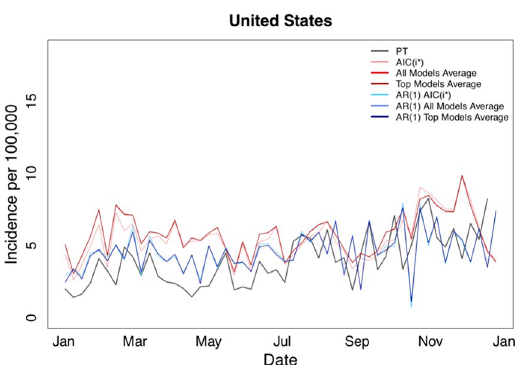
Figure 3. Estimated pertussis incidence per 100,000 population, all modeling methods for the 52-week 2011 forecasting period, United States. Abbreviations: PT: Project Tycho, AIC ( i Models Average: average of 2 n − 1 models using posterior probabilities, Top Models Average: average of few most probable models using posterior probabilities, AR(1): models using the simple AR(1) Cochrane-Orcutt